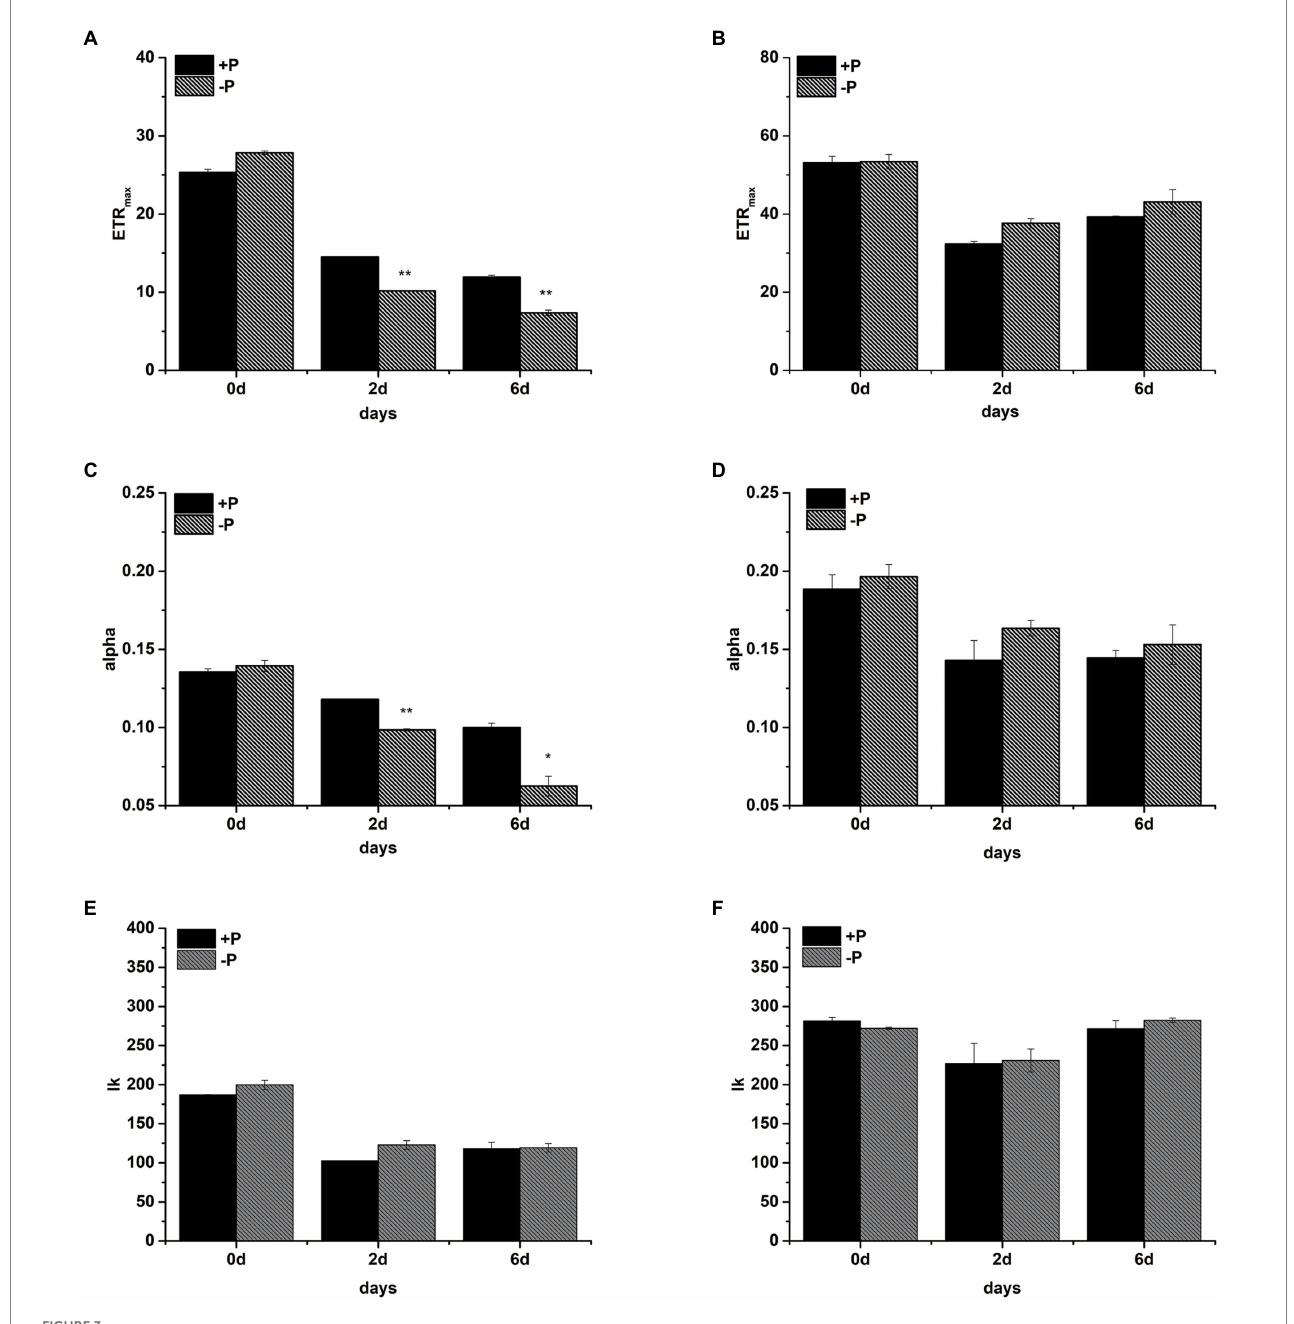
FIGURE 3 The maximum electron transport rate ETR max ( A : S . costatum , B : P . globosa ), light-harvesting efficiency alpha ( C : S . costatum , D : P . globosa ), and the point of light saturation Ik ( E : S . costatum , F : P . globosa ) in +P and − P groups. Error bars show the mean ± standard error (SE) of triplicate treatments. Superscripts indicate significant differences between +P group and − P group according to a two-way ANOVA with a post-hoc test (** p < 0.01, * p <